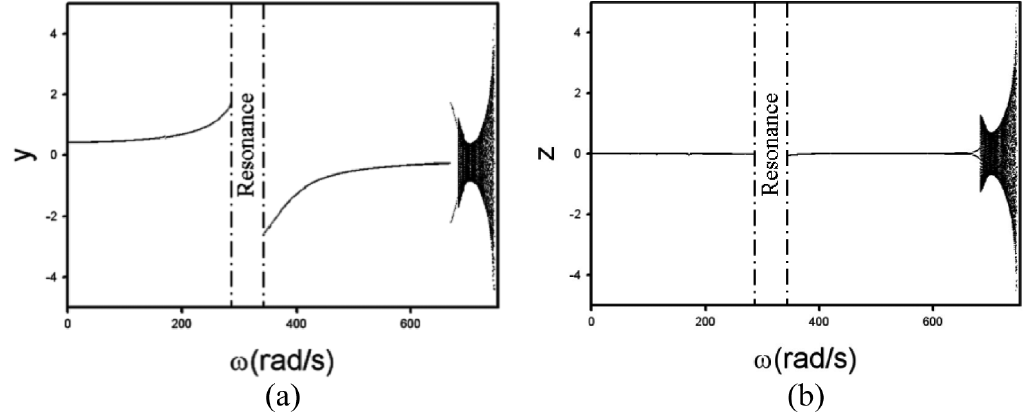
Fig. 8. The bifurcation diagram of displacements at the mid-span point versus rotation speed. (a) y -displacement; (b) z -displacement. D = 0.25 m, γ m = 1000 T 2 m/H, ρ s = 7800 kg/m 3 , E = 206 GPa, C = 0.001 D , C e = D /16000, L = 3 m, L b = D /4, e ¯ m = 0 . 0001 m, x a = 0.08, x b = 0.92, μ o = 0.001 Pa ·